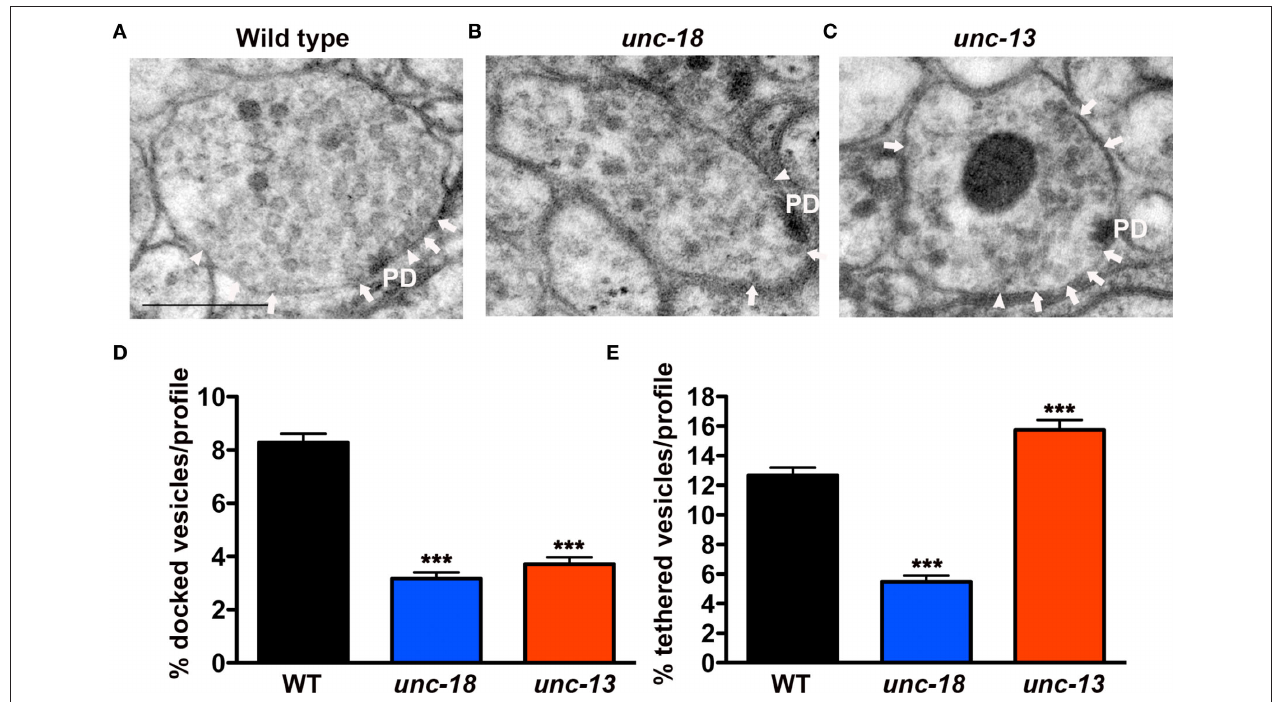
FigUre 1 | unc-18 mutants exhibit defects in vesicle docking and tethering. (A–C) Representative electron micrographs of NMJ profiles prepared by HPF fixation for morphometric analysis from (A) wild-type (B) unc-18(b403) mutant and (C) unc-13(s69) mutant. Arrowheads indicate plasma membrane docked synaptic vesicles, arrows indicate tethered synaptic vesicles ( < 25 nm of the plasma membrane) and PD indicates the presynaptic density. Scale bar 200 nm.